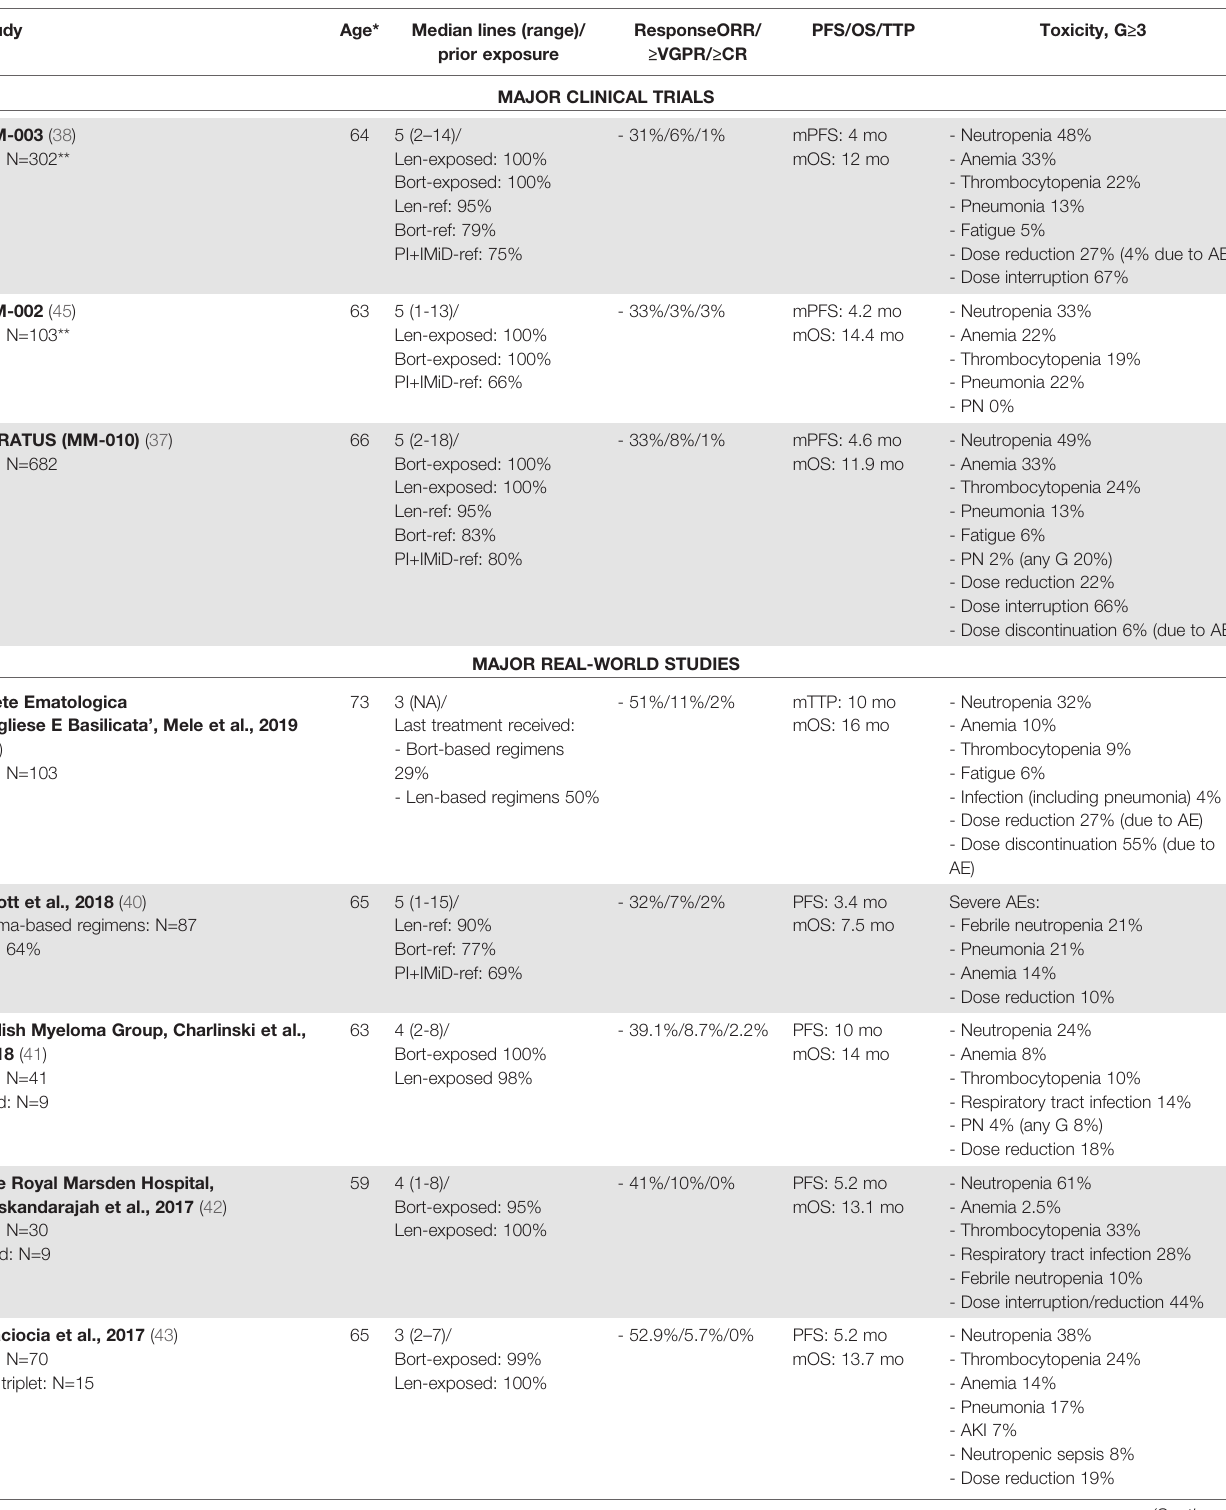
TABLE 2 | Major clinical trials and real-world studies based on pomalidomide for the treatment of RRMM.